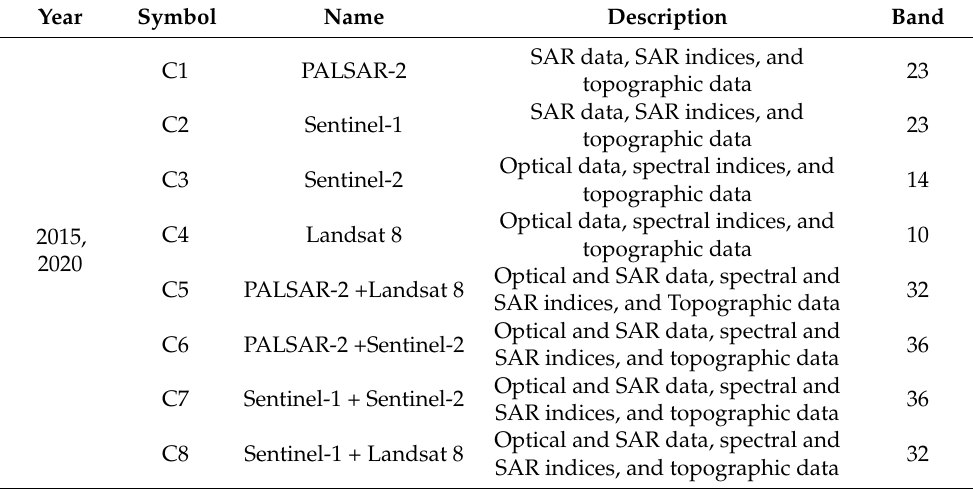
Table 3. Image combination